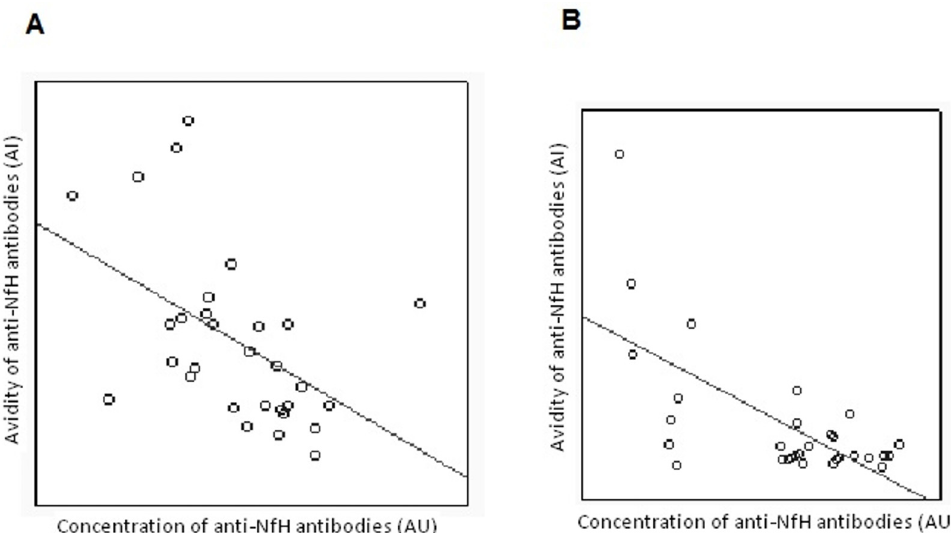
Fig. 4. Relationships between levels and avidities of anti-NfH IgG antibodies. Avidity was determined by ELISA using urea 6 mol/L as chaotropic